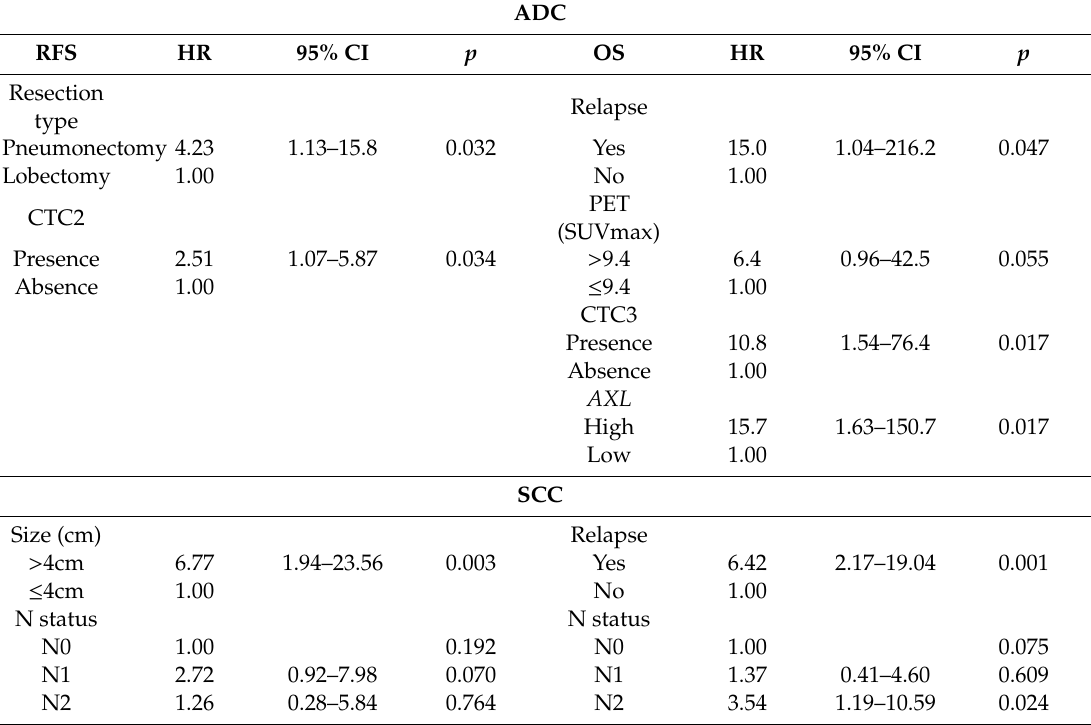
Figure 3. CTCs as relapse prognostic biomarkers and their dynamics in ADC: ( A ) Kaplan–Meier of the influence of CTC2 in the relapse-free survival (RFS). Patients with the presence of CTC2 had 4.34 times higher risk of developing relapse after the surgery versus those without them. Log-rank (Mantel–Cox) test was applied. ( B ) Kaplan–Meier of the influence of AXL tissue expression in the RFS. Patients with high AXL had 4.54 times higher risk of developing relapse after the surgery versus those with low expression. Log-rank (Mantel–Cox) test was applied. ( C ) Swimmer plot showing shorter RFS in patients with presence of CTCs after surgery (CTC2) (orange) versus patients with an absence of these cells (light blue). Follow-up after recurrence is represented in dark blue. Adjuvant therapy was administered after CTC2 extraction in those highlighted with red arrows, finding no significant di ff erences according to the treatment between the two groups. Table 2. Final multivariate Cox proportional hazards regression model for RFS and OS in ADC and SCC.